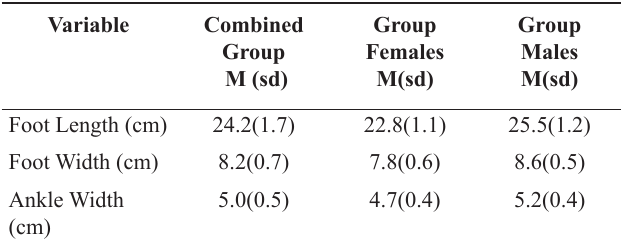
Table 1. Mean and standard deviation of the anthropometric foot